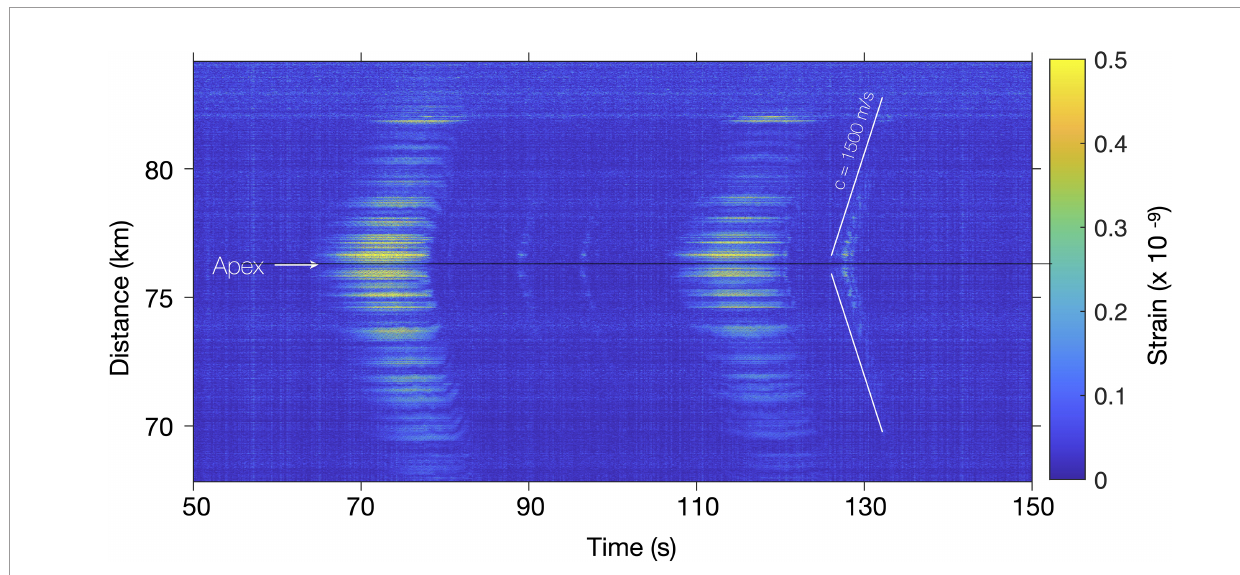
FIGURE 3 | Spatio-temporal representation of blue whale vocalizations recorded on the Svalbard DAS array. The t - x plot displays the temporal variations of the strain between 68 and 84 km of FO cable when receiving two successive stereotyped blue whale calls (at 70 and 110 s), intertwined with down-sweeps (D-calls; at ≃ 90 , 95 and 127 s) recorded on July 10, 2020 at 035530UTC. The channel at 76.6 km was used to produce for the spectrogram in Figure 2D